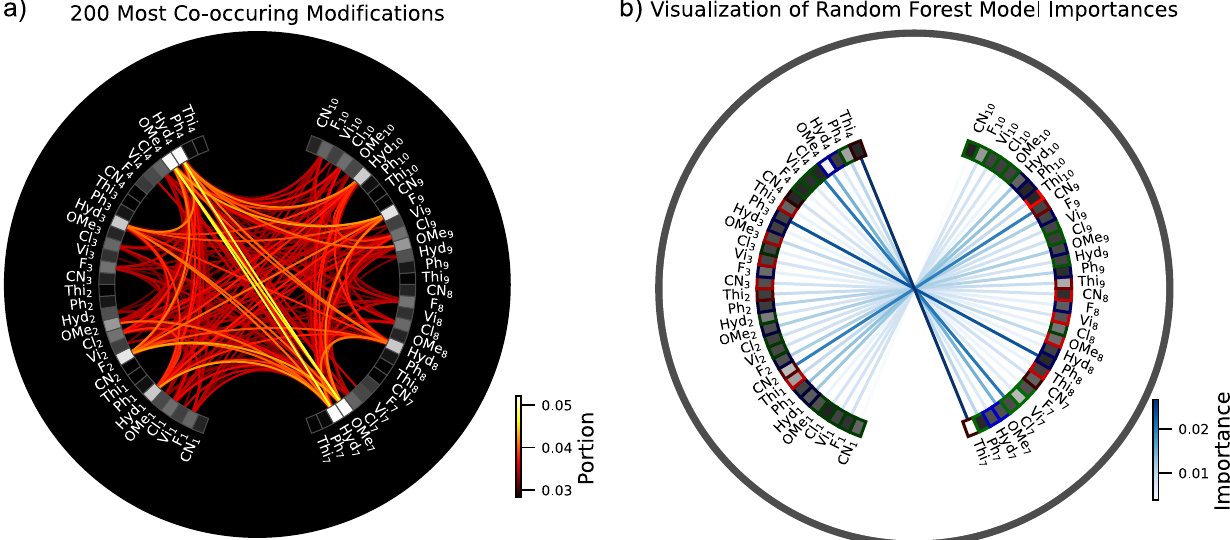
Fig. 5 Most commonly co-occurring combinations of groups and positions. a Plot showing connectivity between pairs of groups and positions, generated using the MNE Python programme package 34 . The brightness of each node indicates how strongly it is included in the connections. b Graphical representation of the learned feature importance of the Random Forest Classi fi er, generated using the MNE Python programme package 34 . The three groups of features, explained in the Methods section, are depicted as follows: Node brightness indicates the importance of individual groups at speci fi c positions ( fi rst group of features). Lines connecting two nodes represent the 'and/or' symmetry- equivalent position information for a chemical group (e.g. hydrogen at either/and R 4 or R 7 ; second group of features). Finally, the brightness of the colour-coded node borders speci fi es the importance of typical, average, or uncommon groups (blue, green and red, respectively; third group features). The exact importance values can be found in Supplementary Table 2 of the